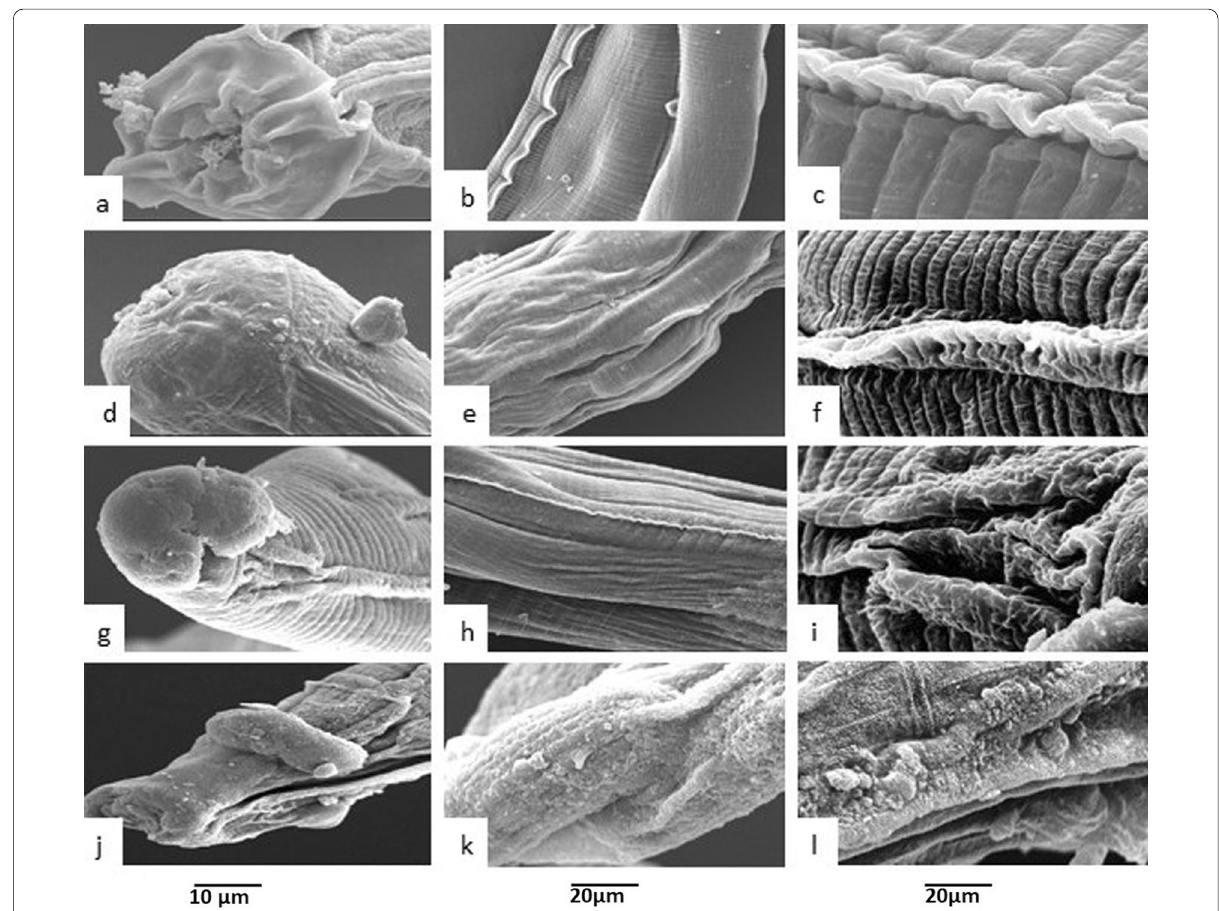
Fig. 3 Scanning electron micrographs of adult S. obveleta . a Control worm in apical view showing three lips with cephalic vesicles, anterior cervical alae and disposition of sub median cephalic papillae; b , c Control worm representing fine transverse striations in cuticle; d – f worms exposed